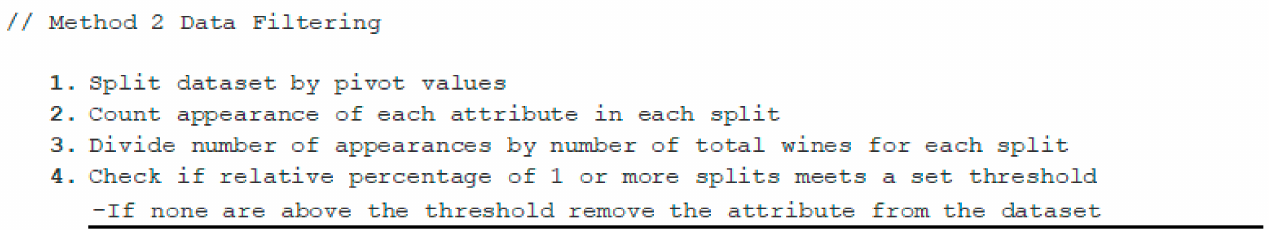
Figure 5. Pseudo code for the filtering method 2: Wine Grade Filtration + Attributes Filtration. The pivot value can be changed, but for our example we utilize a pivot based on